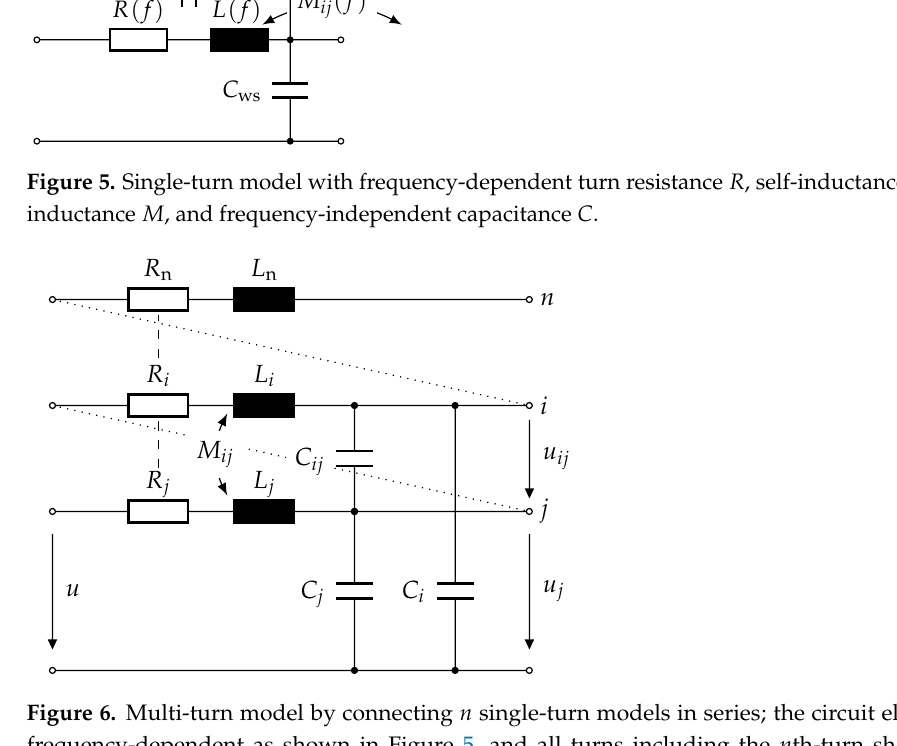
Pool of frequency sam- ples and associated data f n − 1 f n f 1 f 2